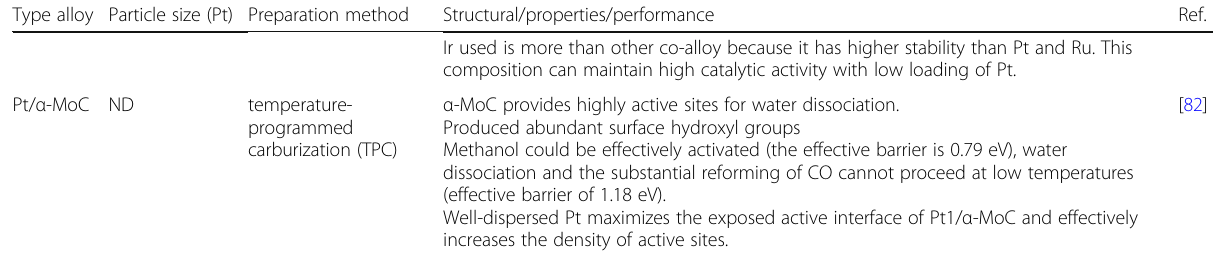
Table 1 Various type of Pt bimetallic, tertiary, and quaternary metal alloys and their performance (Continued) Type alloy Particle size (Pt) Preparation